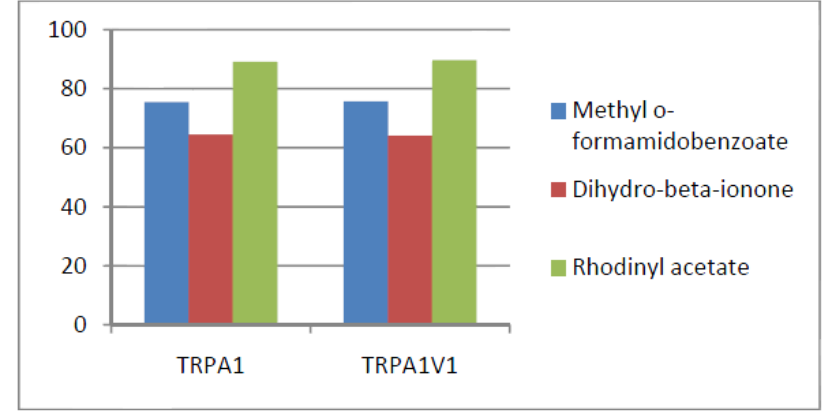
Figure 5. Examples of compounds that activate TRPA1 = TRPA1V1, but not TRPV1.